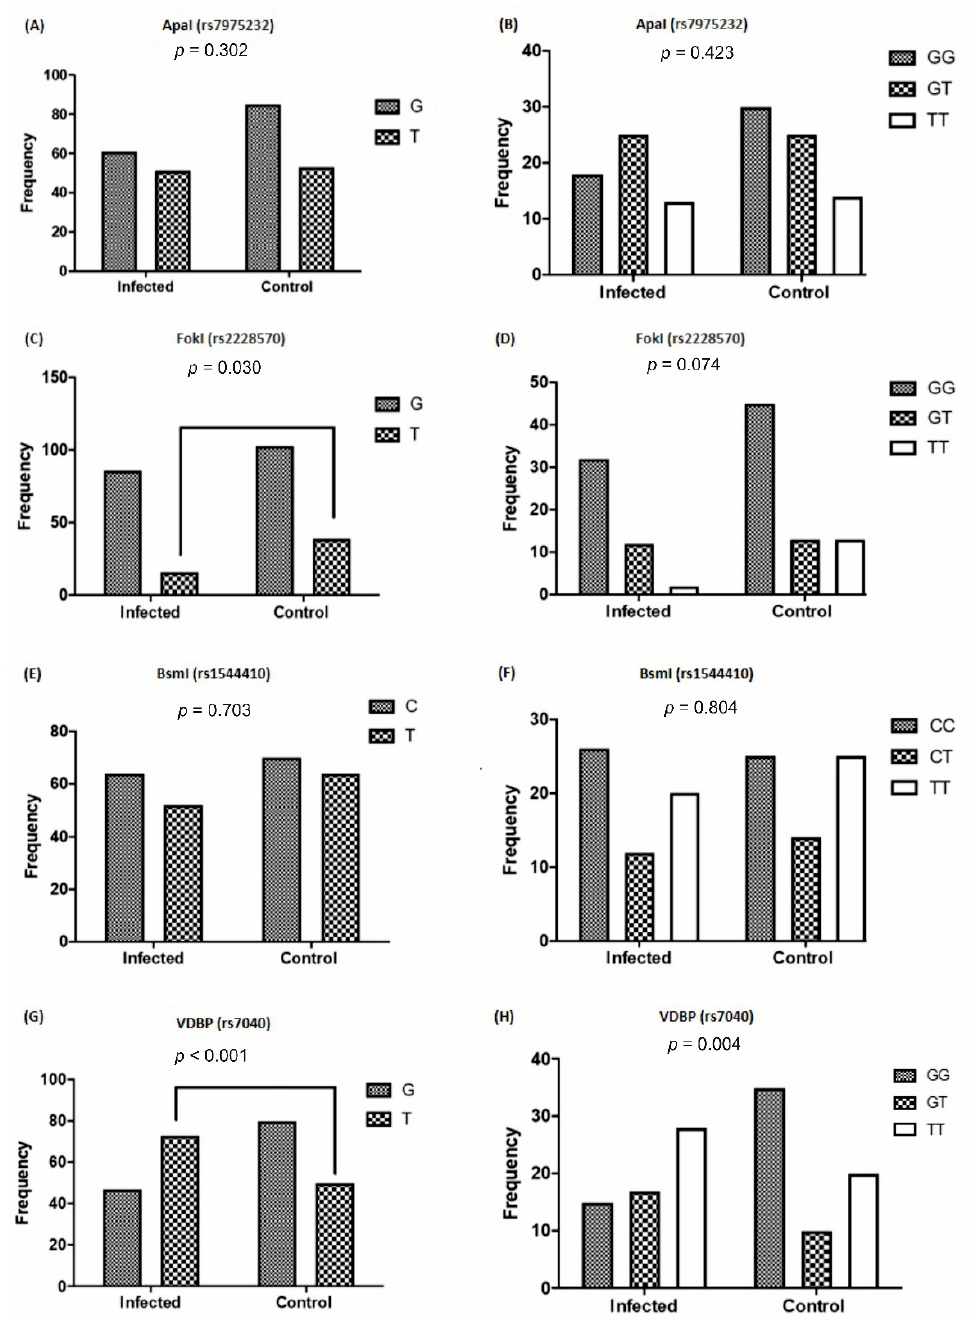
Figure 5. Comparison of the allele and genotype frequencies of VDR and VDBP polymorphisms in the recipients with a history of viral infection and healthy individuals. ( A , B ) Apa I, ( C , D ) Fok I, ( E , F ) Bsm I, and ( G , H ) rs7040 polymorphisms. VDR: vitamin D receptor; VDBP: vitamin D-binding protein.